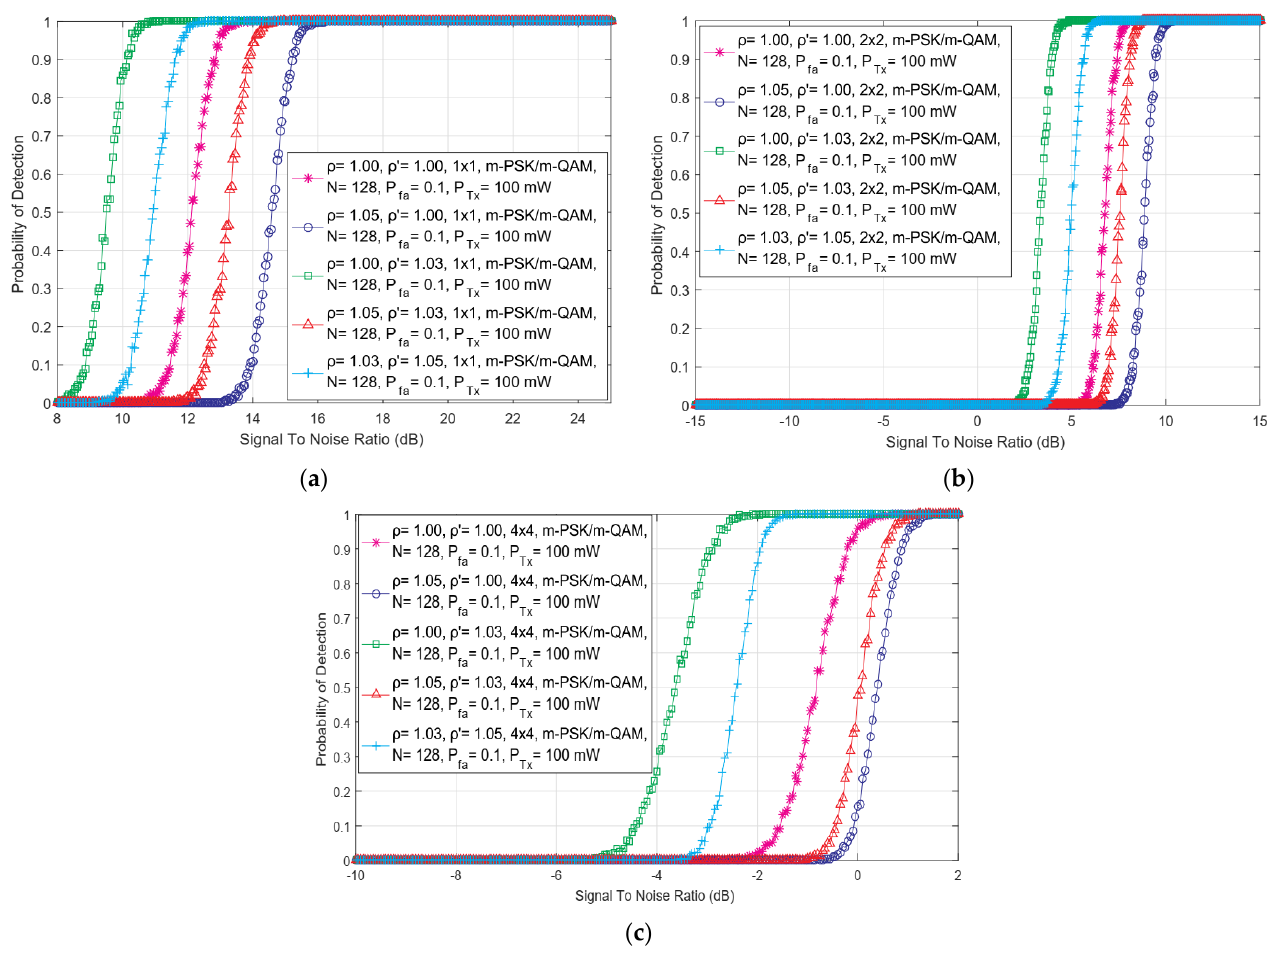
Figure 2. The dependency of detection probability on SNR for ED performed with different combi- nations of DDT and NU factors in ( a ) SISO, ( b ) symmetric 2 × 2 MIMO and ( c ) symmetric 4 × 4 MIMO communication systems.